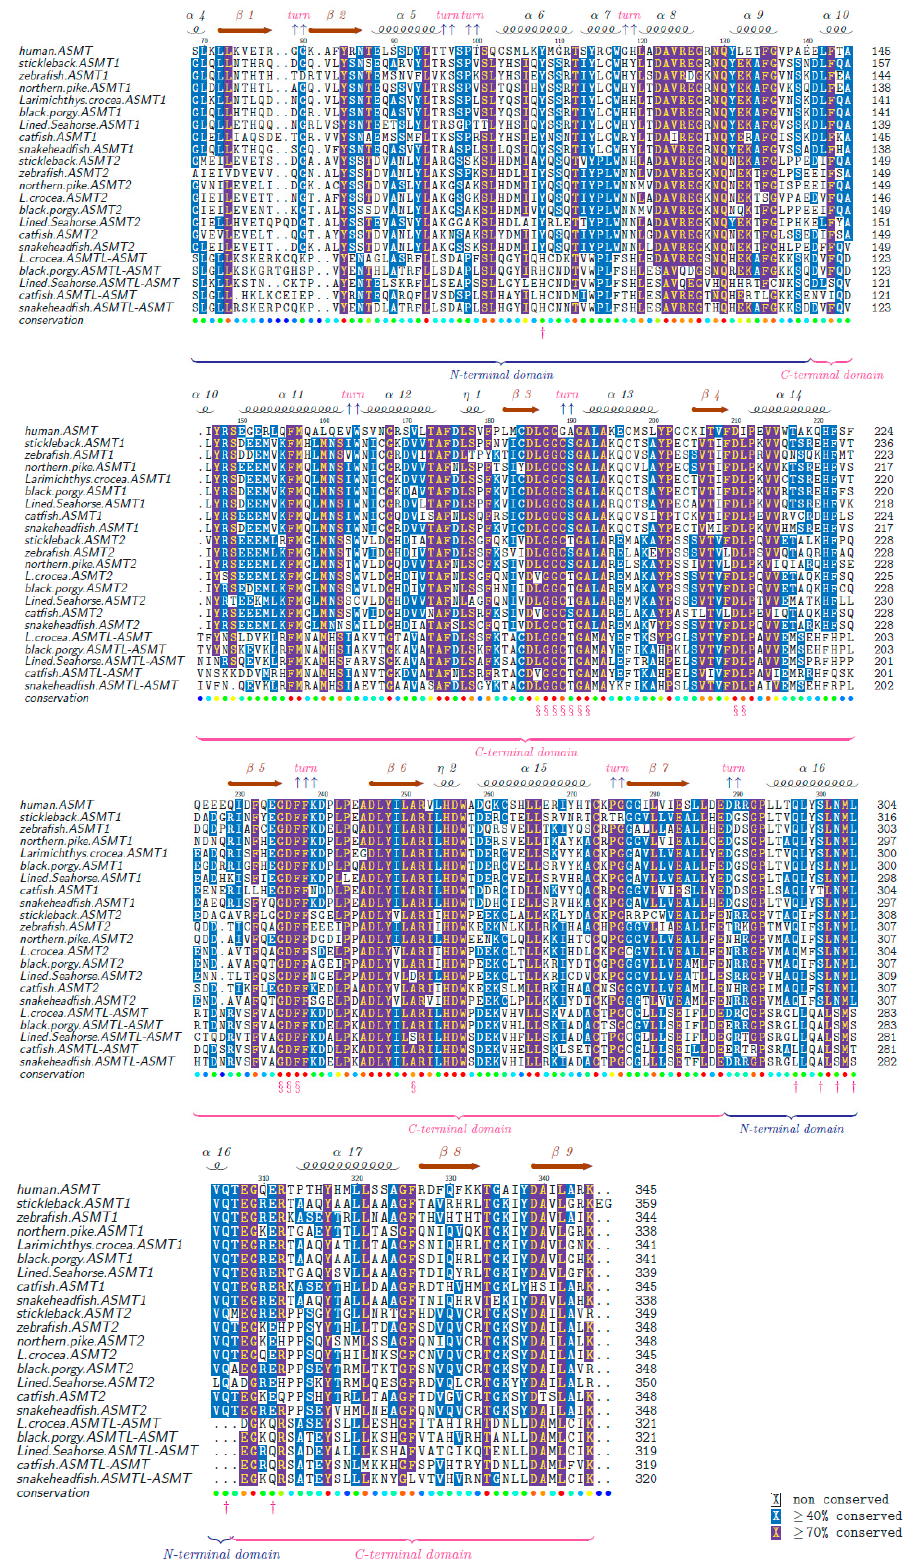
Figure 5. Alignment of ASMT protein sequences. These sequences were aligned with human ASMT by MAFFT and colorized using TEXshade. The secondary structural elements, alpha helix ( α ) and beta strand ( β ), are marked. Please note the remarkably conserved SAM binding residues (§). Residue differentiation between ASMTL-ASMT and other two ASMTs are marked using a dagger (†). Numbering is referred to the human ASMT. The color code for the conservation track ranges from red (the most conserved) to blue (the least conserved) as per